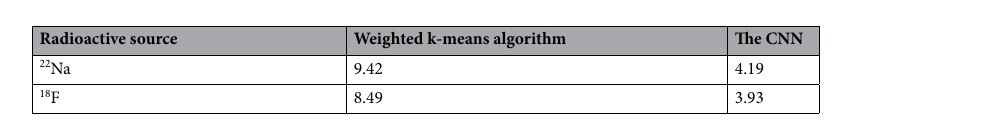
Table 2. The RMSE [mm] of Ps localization based on the weighted k-means algorithm and the CNN-based reconstruction corresponding to the radioactive